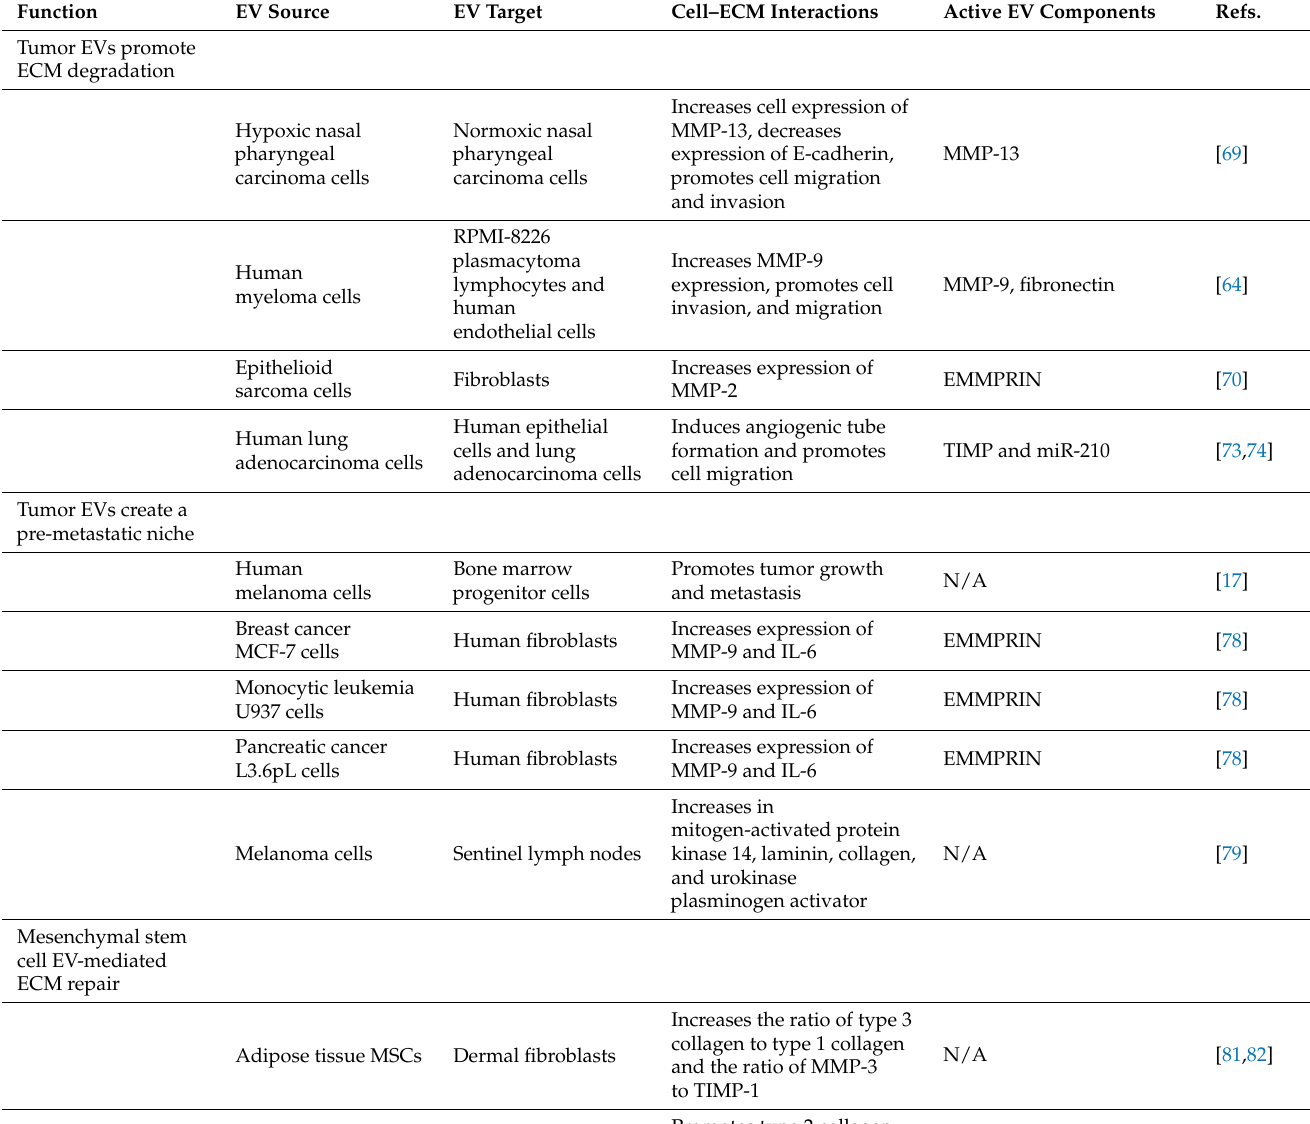
Table 2. Indirect effect of EVs on the